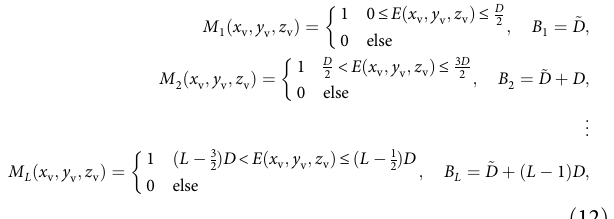
Fig. 5: On the left of the fi gure, one distance shift B 1 is used for reconstructing both spatial regions M 1 and M 2 which is equivalent to using one section. On the right, two different